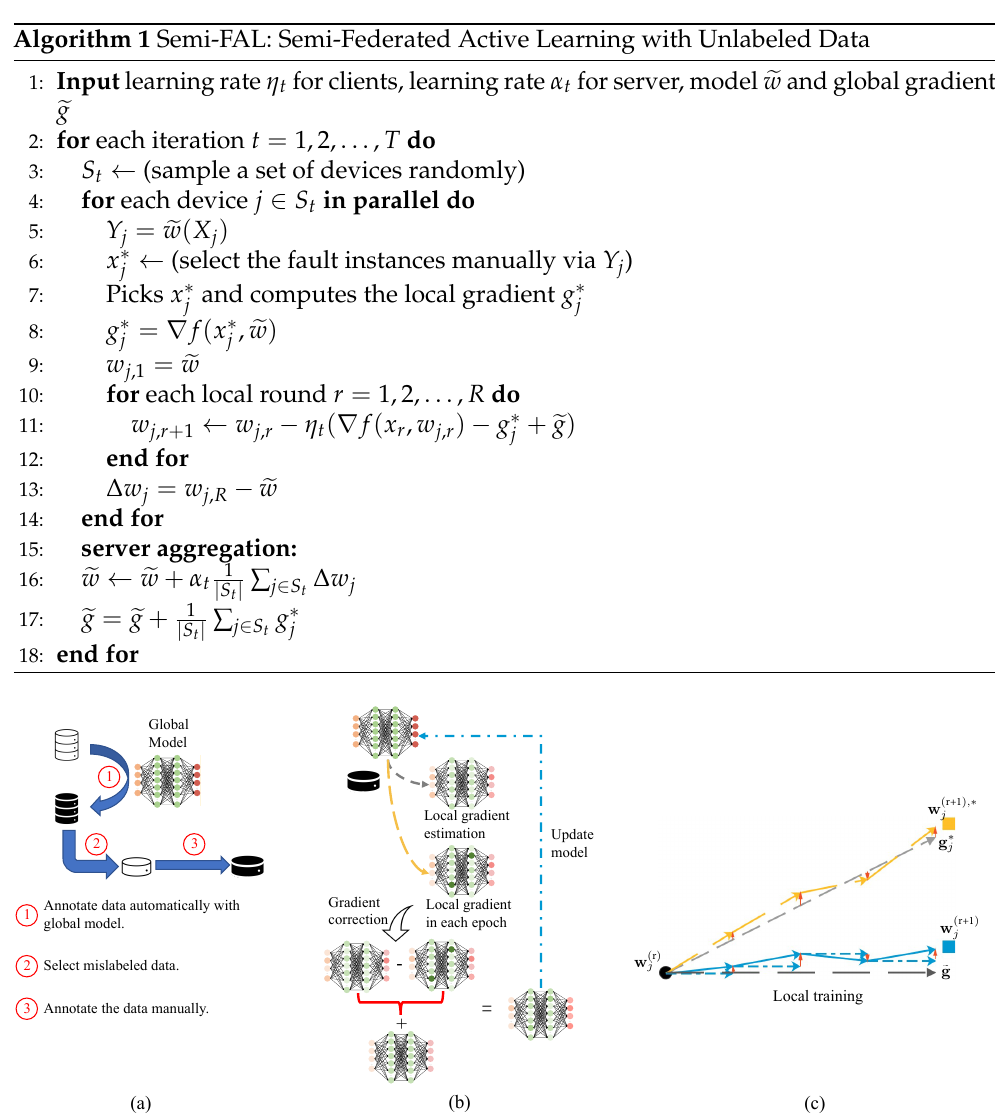
Figure 2. Detailed design of the collaborative data annotation and model training architecture in each client. ( a ) The annotation process of semi-FAL. The mislabeled data would be picked and labeled manually after being labeled by the model. ( b ) The model training process of semi-FAL. The semi-FAL uses gradient correction to direct the local gradient. ( c ) The update direction of local